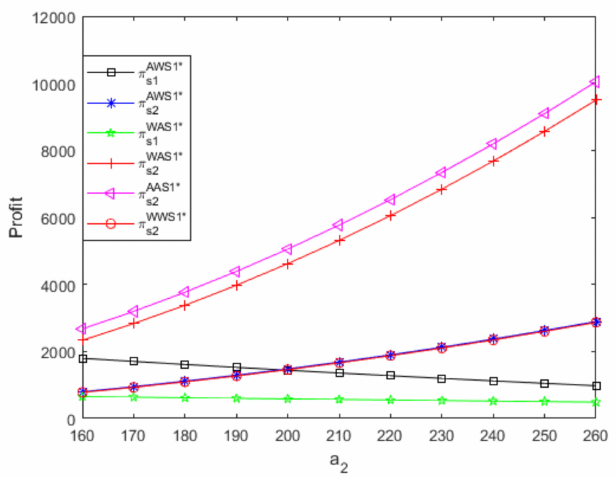
Figure 7. Changes of optimal retail prices with a 2 in AWS1 and WAS1 models.